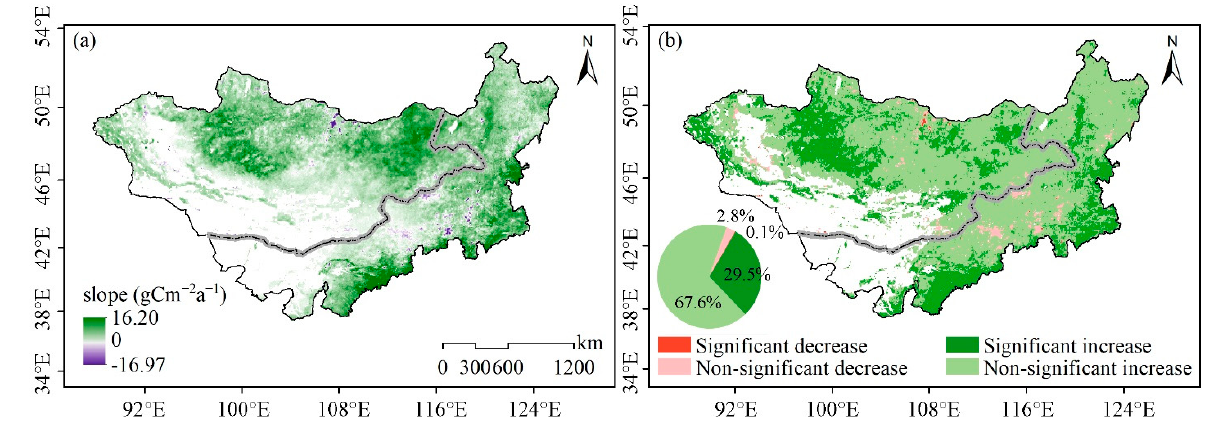
Figure 6. ( a ) Rate of change for vegetation ANPP, ( b ) and significance of the change, in the Mongolian Plateau from 2000 to 2019.